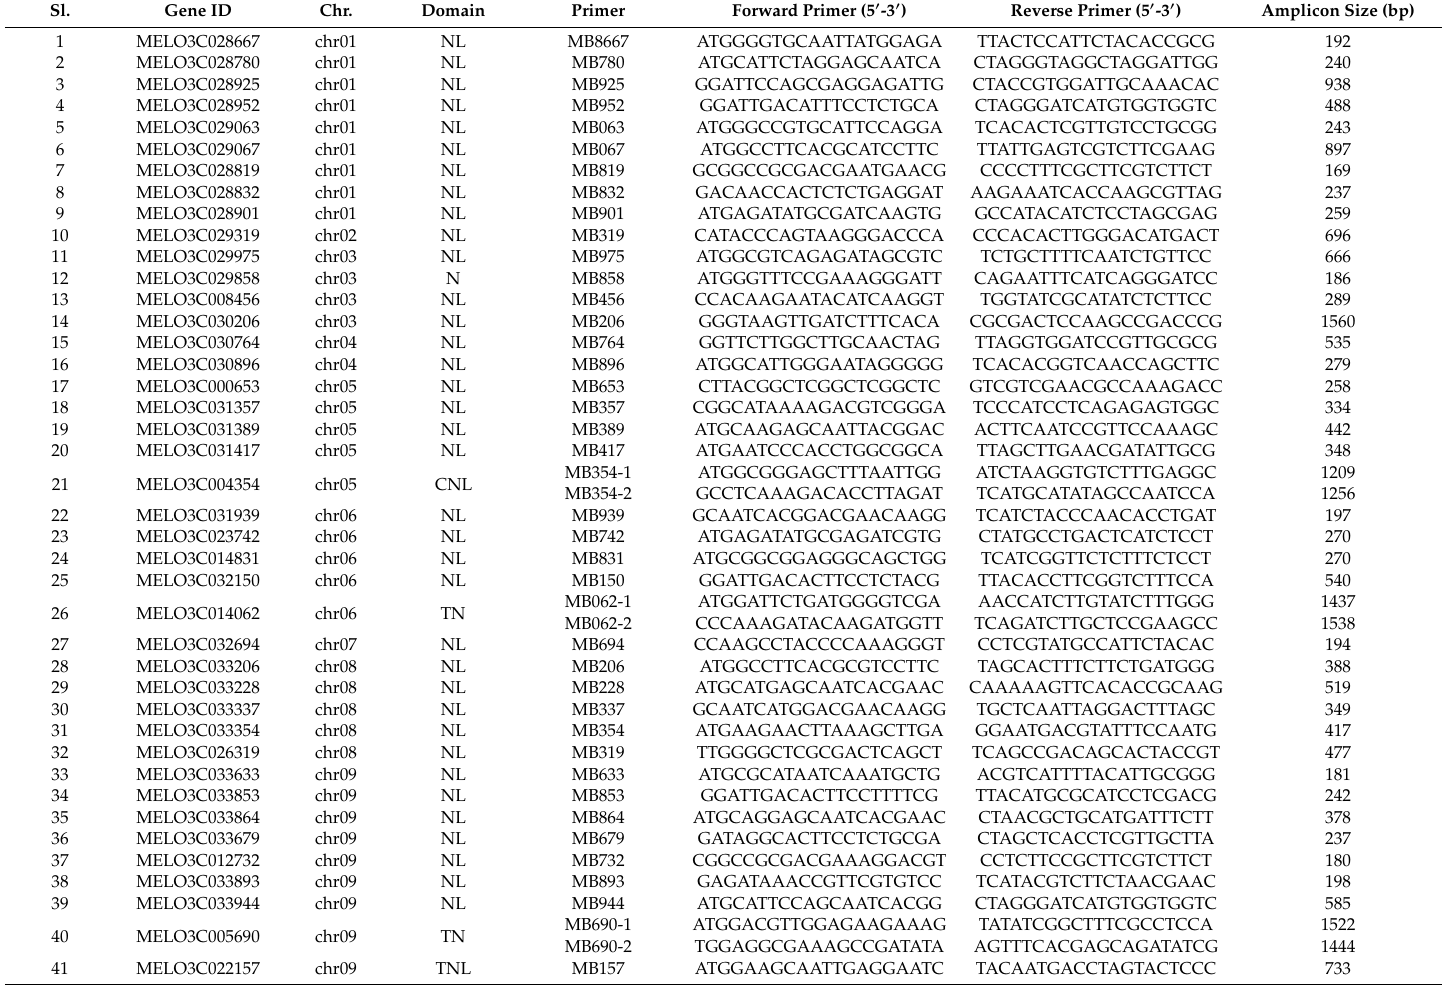
Table 1. Details of 57 putative disease resistance-related genes and corresponding primers used for detecting length polymorphism between resistant and susceptible melon